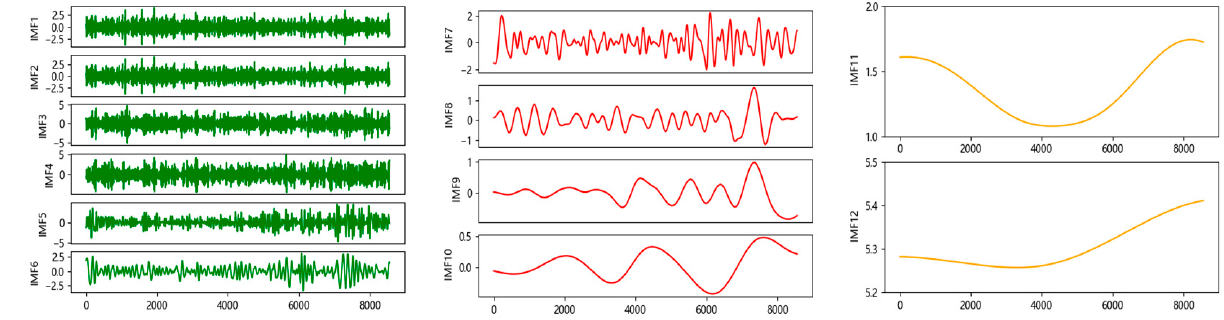
Figure 6. High − frequency modal, low − frequency modal, and trend components. The wind speed time series contained a total of 8760 sample points. In this study, the first 70% of the data—namely, 6132 pieces of data—were used as the training set, and the last 30% of the data—namely, 2628 pieces of data—were used as the test set. According to the parameter tuning experiment and the grid parameter optimization algorithm, the hyperparameters of the network model were set, as shown in Table 2—where the time step unit was 1 h and 24 historical wind speed samples were used to predict the wind speed in the next 1 h. The LSTM network consisted of two LSTM layers; Dense fully connected the layers, and Composition set the dropout layer after the LSTM layer to prevent overfitting. Meanwhile, the GRU network consisted of two GRU layers; Dense fully connected the layers, and Composition set the dropout layer after the GRU layer to prevent overfitting. The experiments were run on an Intel Core i7-12700H, 2.30 GHz CPU with 16 GB RAM, and an Nvidia RTX 3060Ti GPU. The run times for all models are shown in Table 3 below. The parameters of models were as shown in Table 4. Table 2. Grid search algorithm parameter setting.